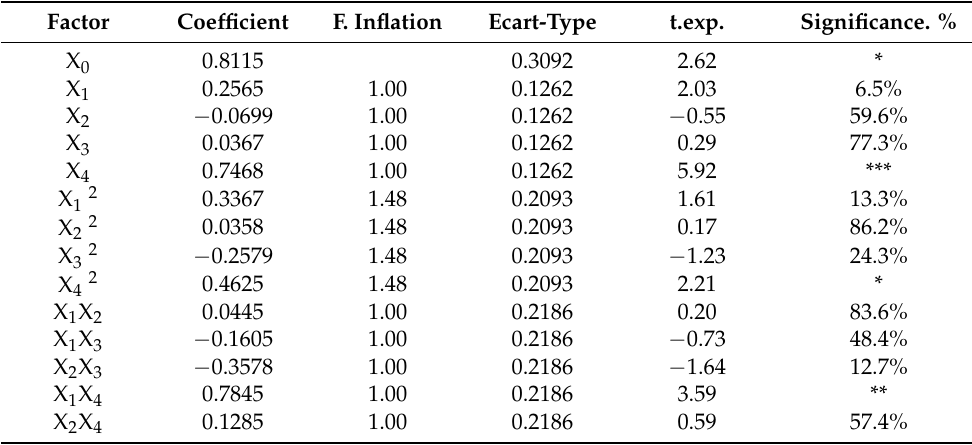
Table 8. Statistical analysis of the coefficients for PE production. Factor